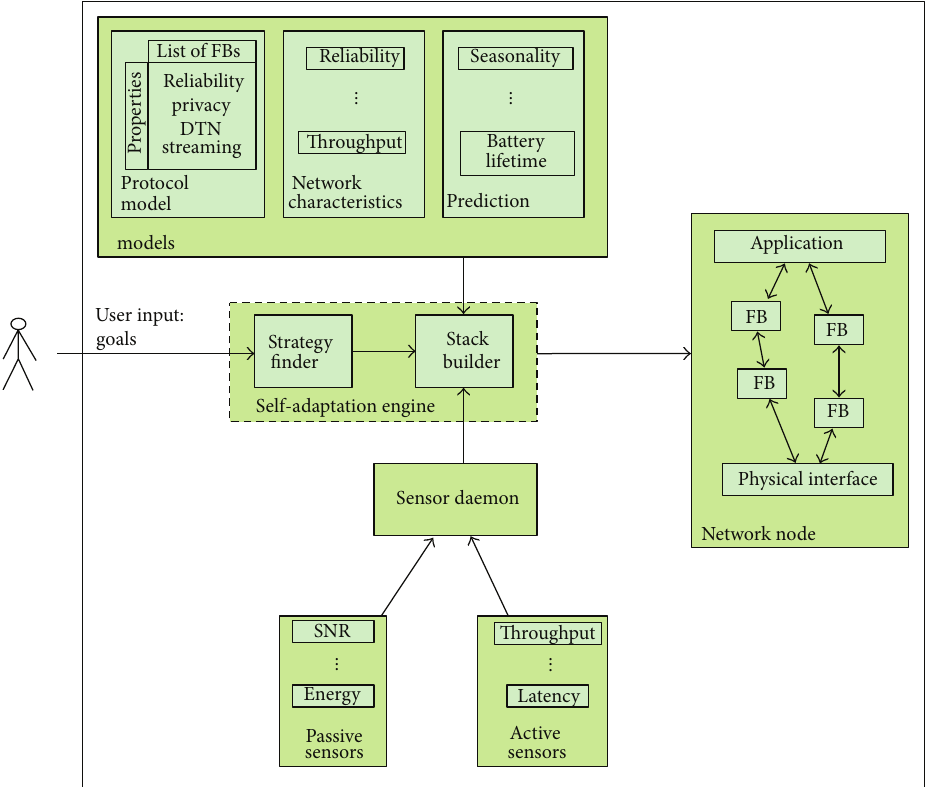
Figure 1: Overview of the self-aware node architecture.